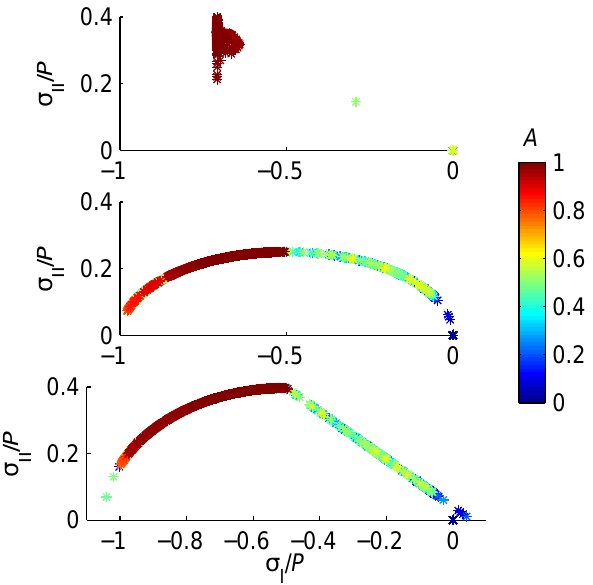
Fig. 14. Stress states using the granular model (top), the elliptic yield curve (centre) and modified Coulombic yield curve (bottom) after eight model days plotted in stress invariant space. The colour scale indicates the ice concentration at each point ( A ) and points with high concentration are drawn on top of those with a lower con- centration. Points with high values of A ( A & 0.8) are all located in the region σ I ≤− P/ 2. Points near the open boundary are excluded from the